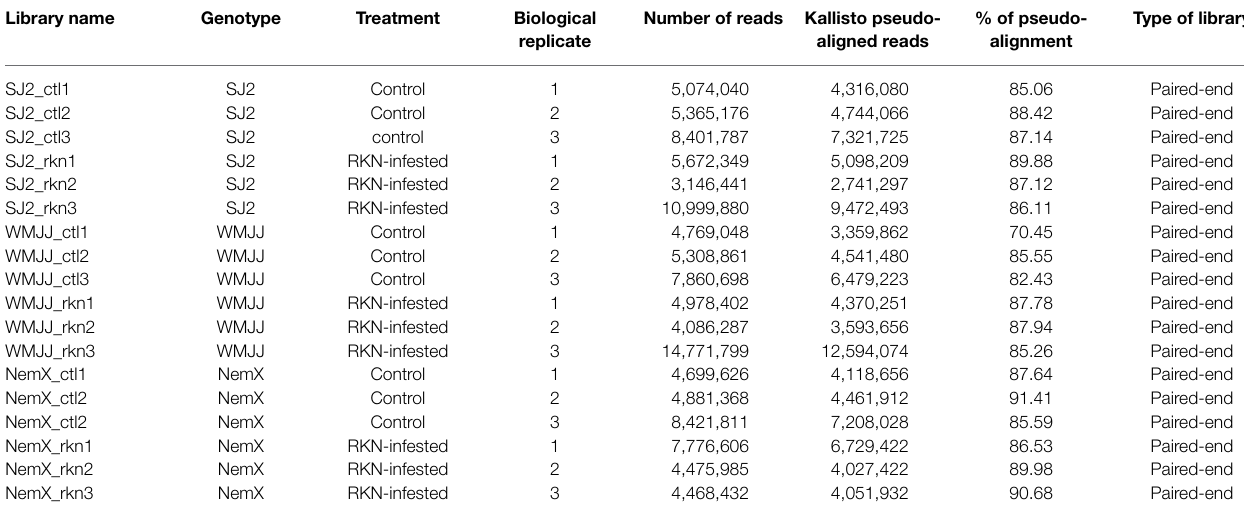
TABLE 1 | Alignment statistics and information about the 18 RNA-seq libraries generated in this study. All libraries were sequenced using Illumina technology and aligned to Gossypium hirsutum TM-1 UTx v2.1 genome (Chen et al., 2020). Library name Genotype Treatment Biological